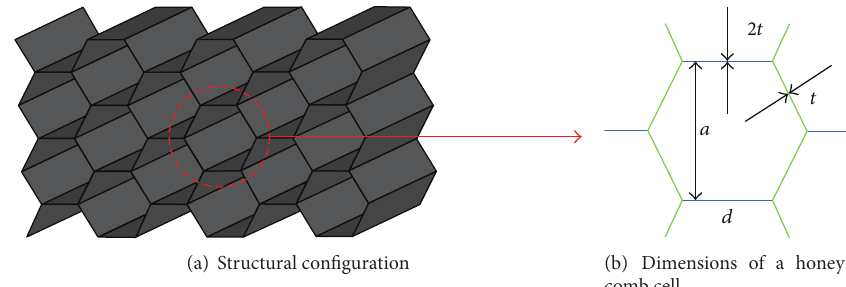
Figure 1: Aluminium honeycomb core geometry.